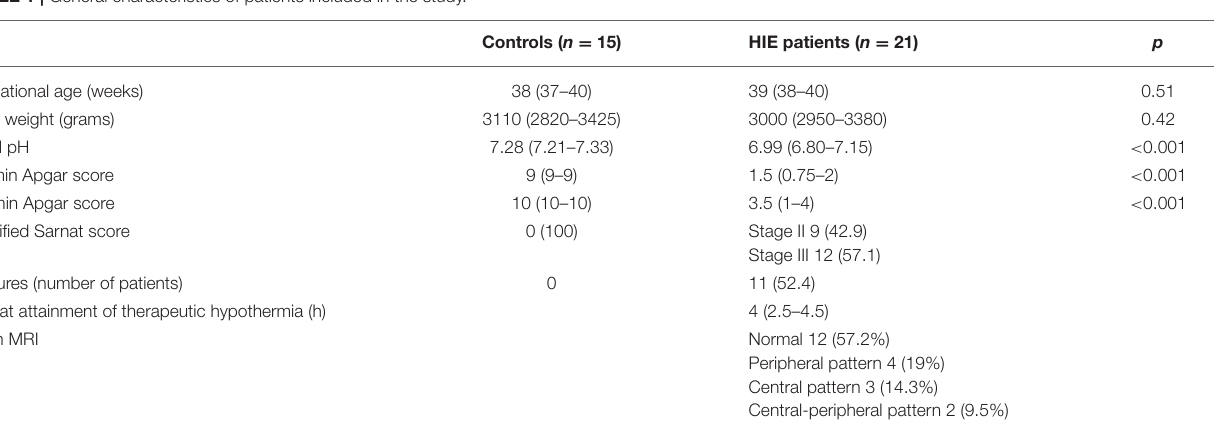
TABLE 1 | General characteristics of patients included in the